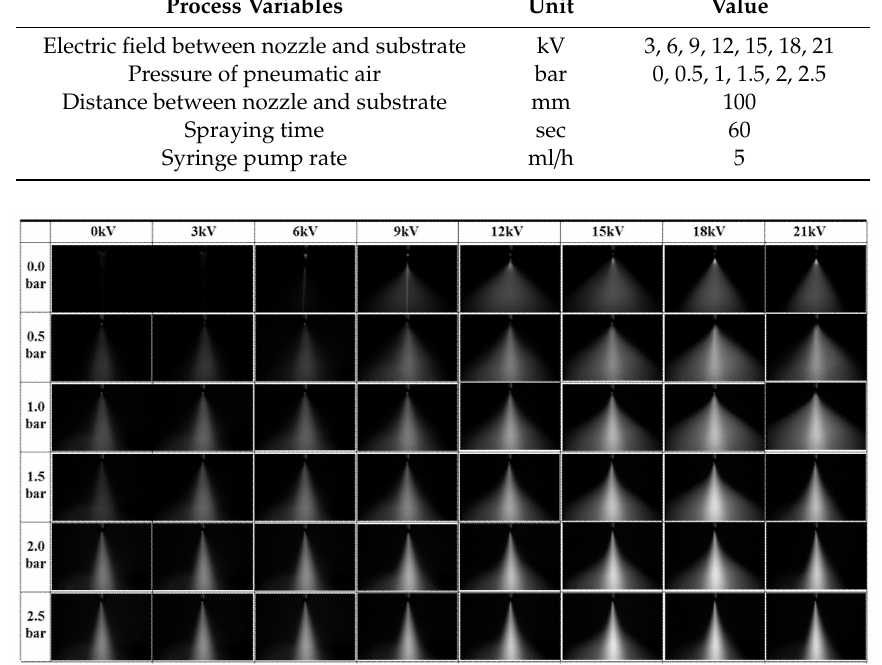
Figure 3. Dispersion images gathered by the split test of the electric fields and the pneumatic